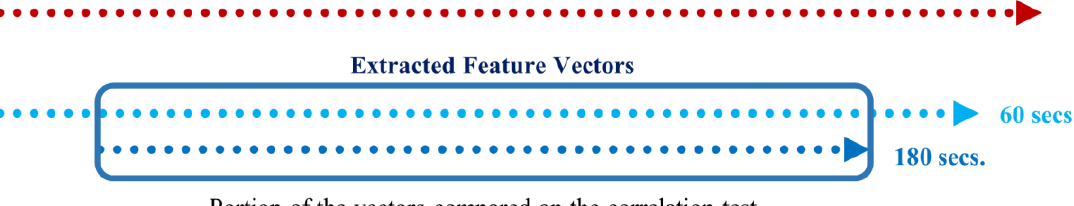
Figure 9. Schematic of the portion of two feature vectors compared in the correlation test, extracted using 180- and 60-second sliding windows with 1-second steps .